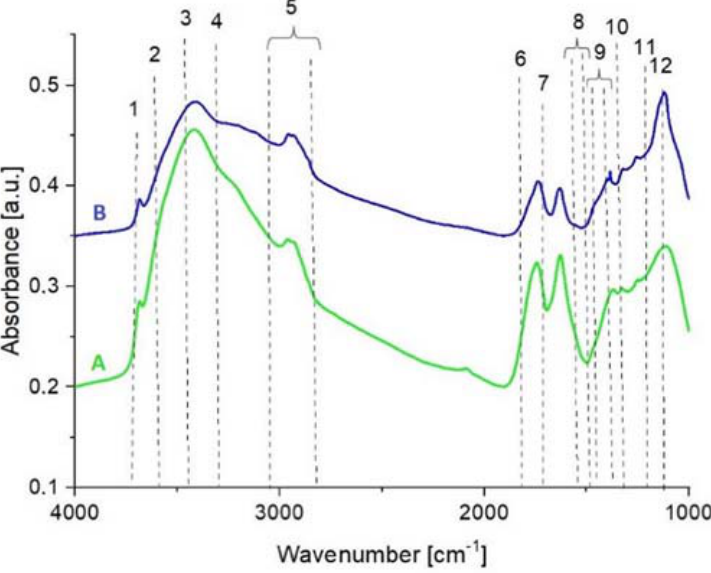
Figure 9. FTIR spectra of unmodified diamond nanoparticles DND (A), and plasma–chemically modified diamond nanoparticles MDP1 (B).